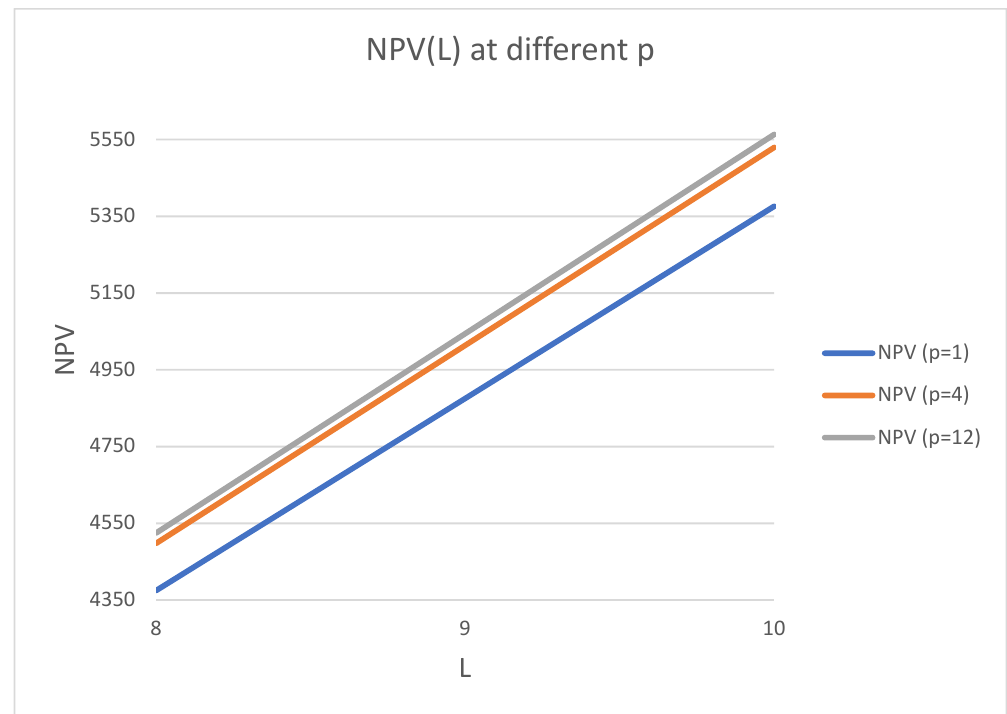
Figure 11. Change of net present value, NPV, with leverage, L , for k d = 0.14; k 0 = 0.22; p = 1, 4, and 12; and n = 3 (larger scale).